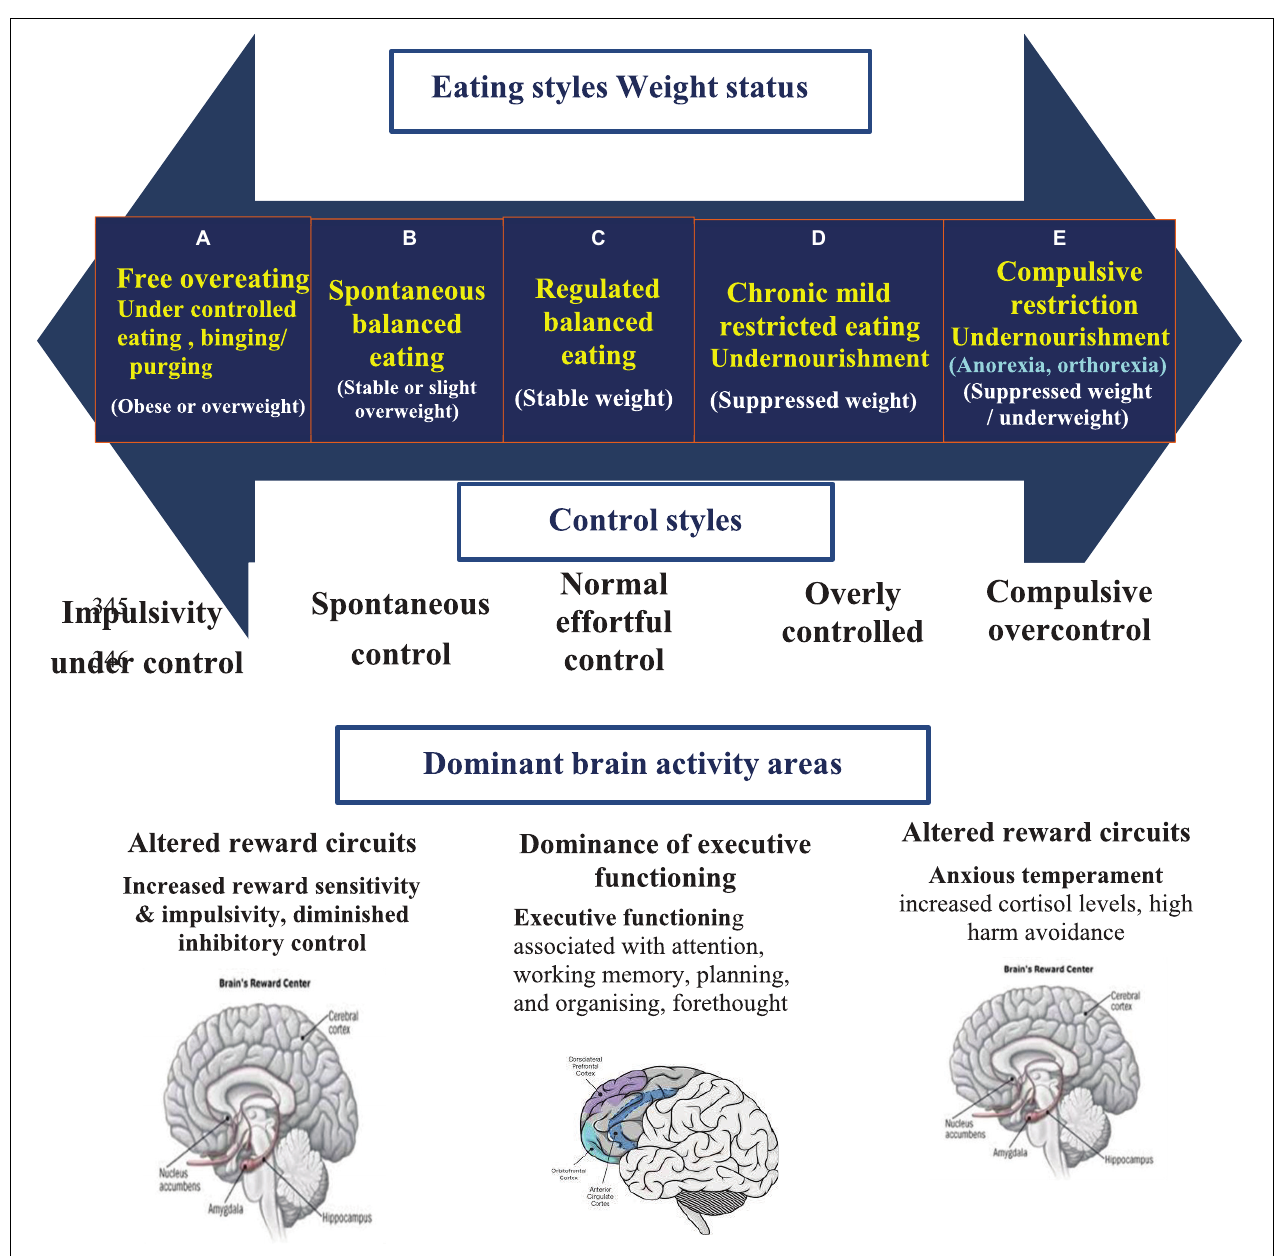
FIGURE 1 | Eating and control styles axis (ECOSA) and the dominant brain